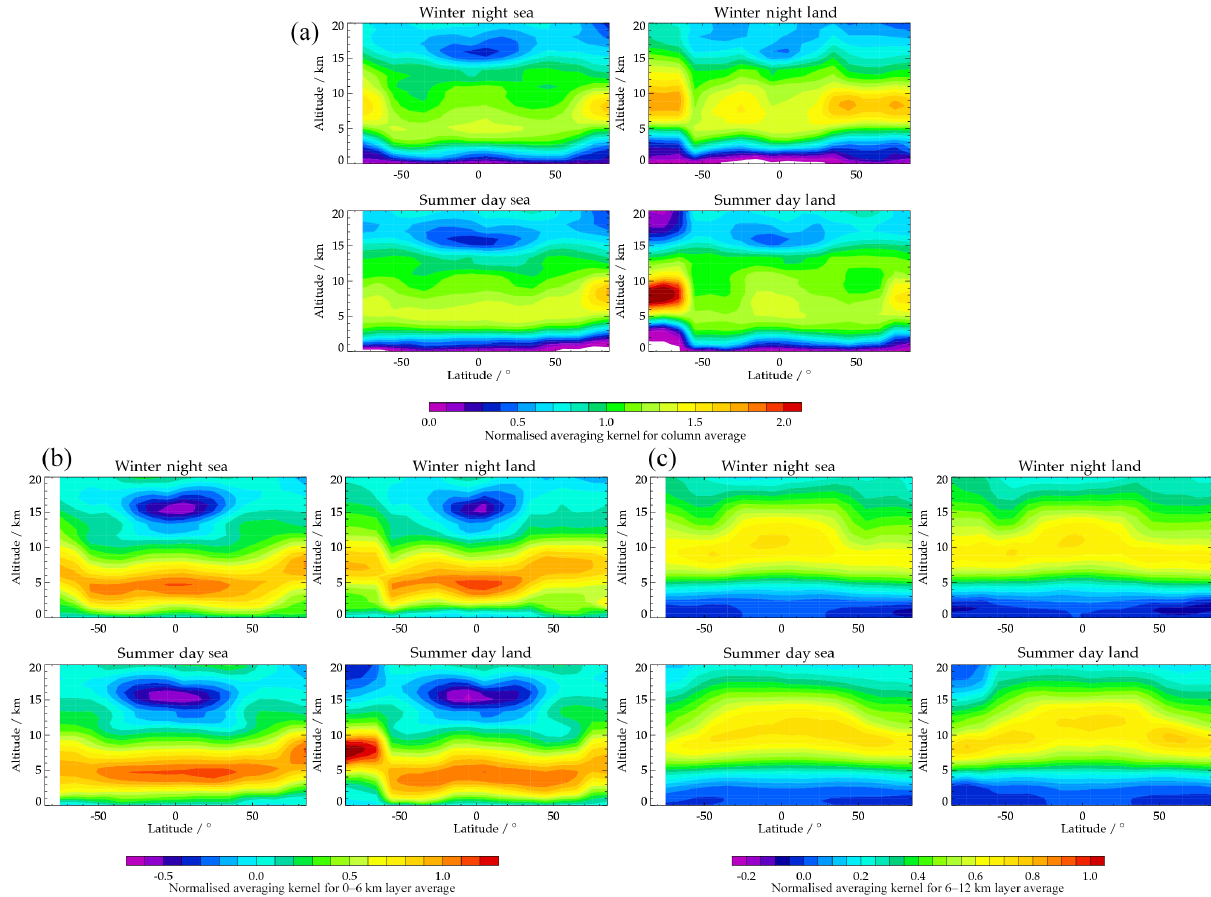
Figure 4. Averaging kernels for methane column average (a) , 0–6km layer average (b) and 6–12km layer average (c) , as a function of latitude and season, for observations over sea, daytime land and night-time land. Kernels are normalised as in Fig.